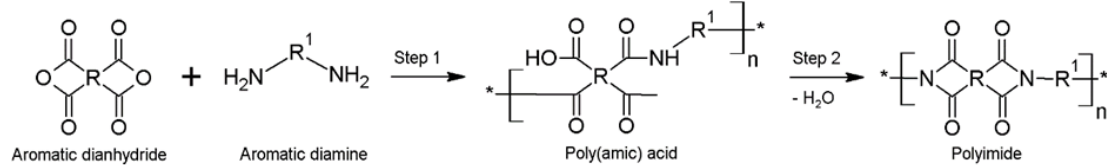
Figure 1. The schematic representation of a two-step synthesis method of polyimide through the formation of poly(amic) acid (PAA) and followed by an imidization process to produce polyimide. R and R 1 are aromatic compounds.